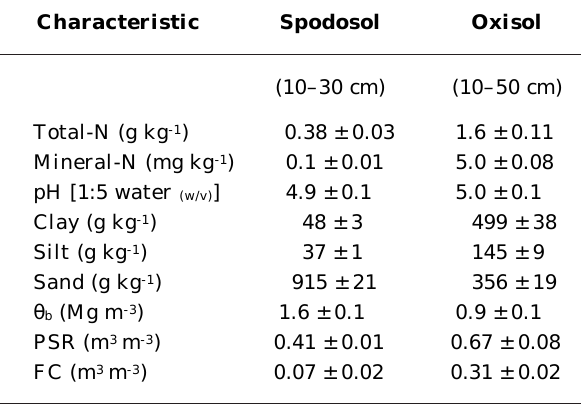
Table 2. Some characteristics of the two selected soils (means ± standard deviations, n = 3)